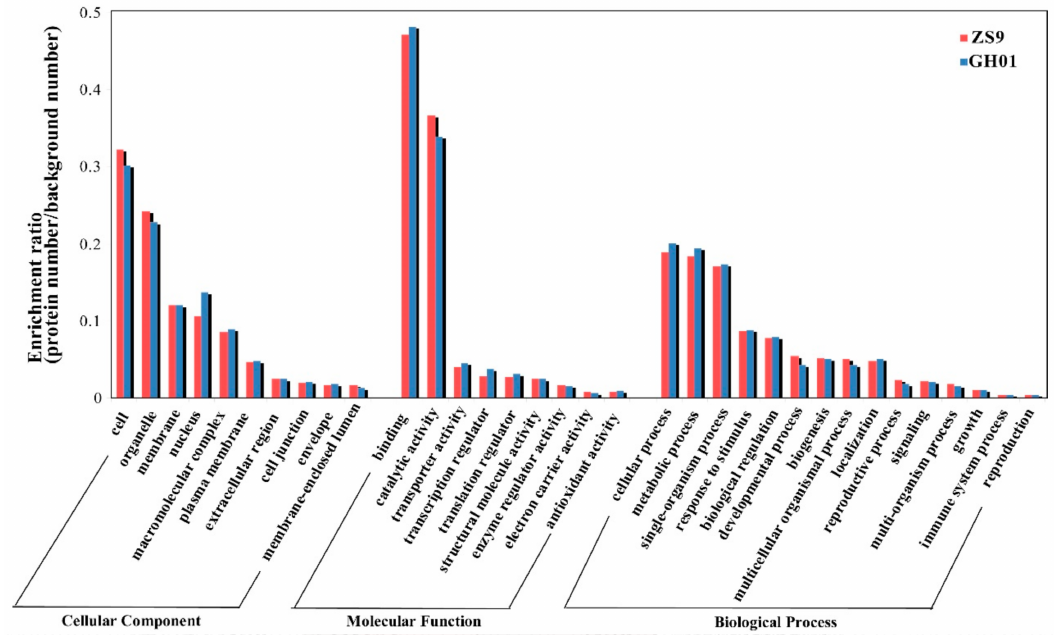
Figure 4. Histogram of significantly enriched proteins in gene ontology (GO) terms grouped with cellular component, molecular function, and biological processes between ZS9 and GH01. Left y -axis represents the ratio of proteins (protein numbers/background protein numbers) enriched in each GO